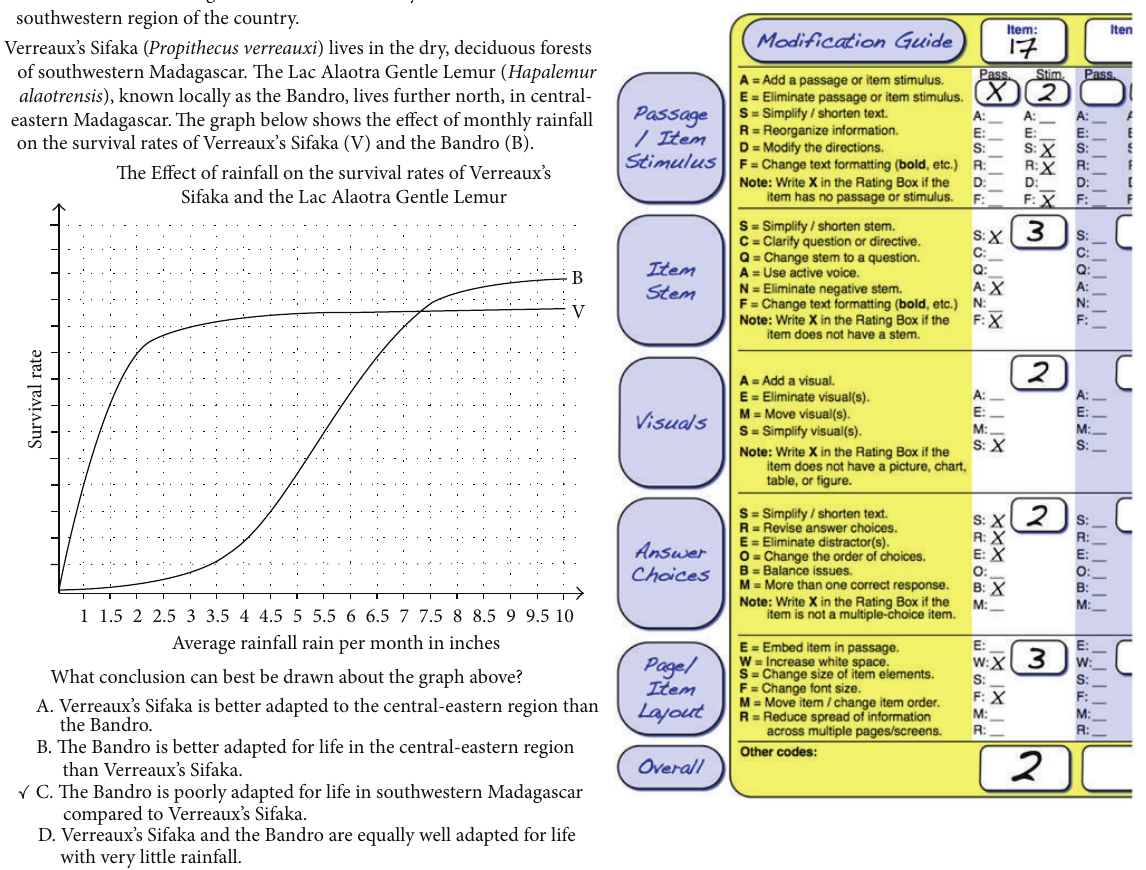
Figure 4: Grade 10 science item with ARM ratings,